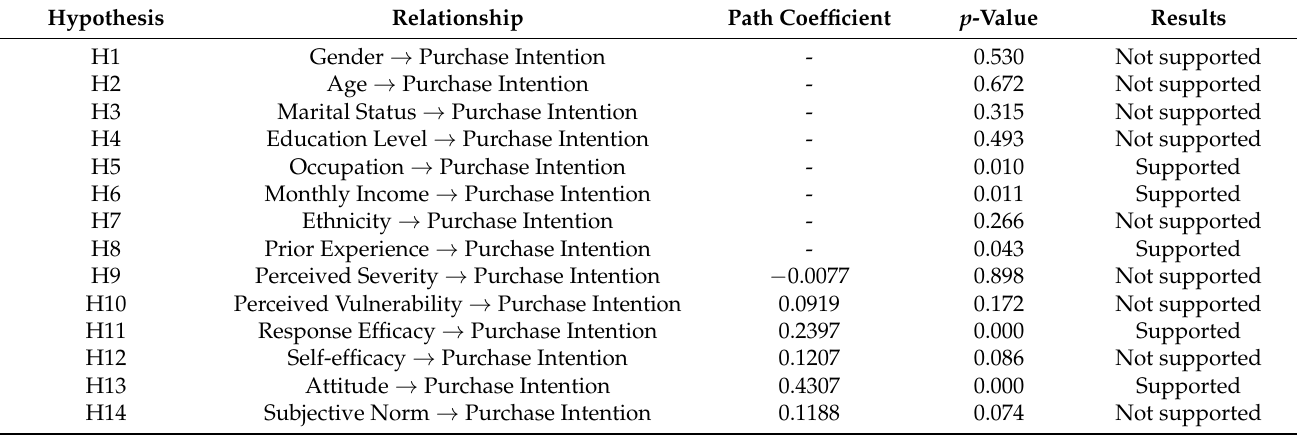
Table 7. Summary of the results for hypotheses H1 to